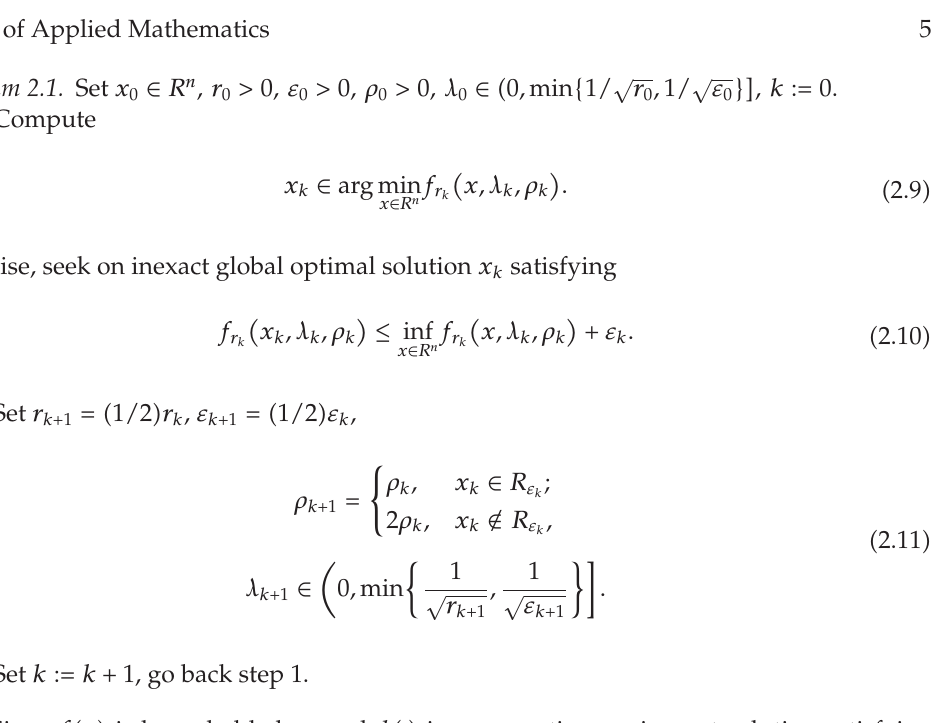
√ √ r 0 , 1 / ε 0 } (cid:8) , k : (cid:4)